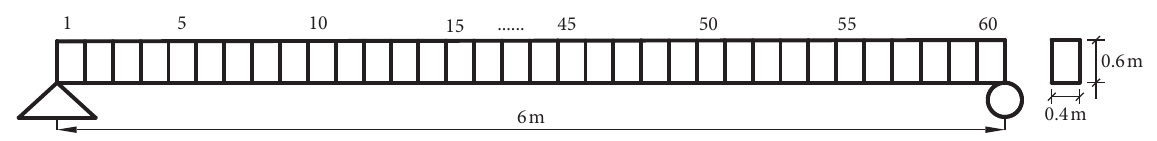
Figure 10: Simply supported beam Finite element model. Table 1: Damage case studies in simply supported